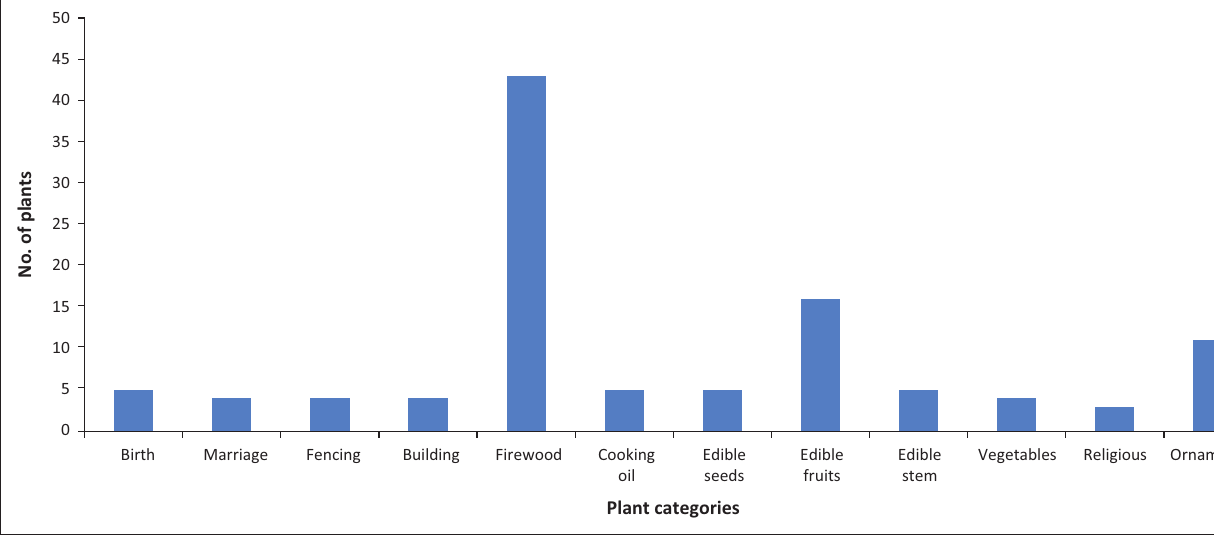
FIGURE 3: Economic uses of Otuo plants.